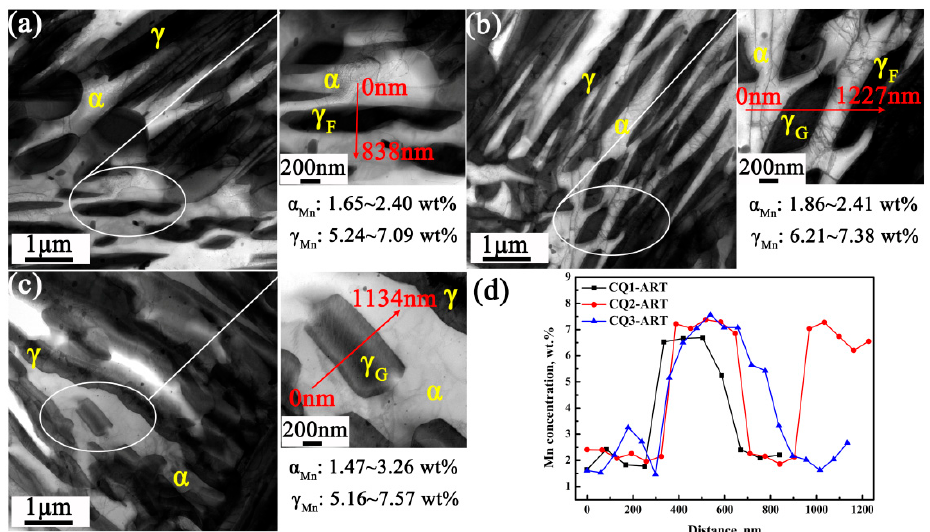
Figure 5. ( a ) TEM image of the CQ1-ART sample; ( b ) TEM image of the CQ2-ART sample; ( c ) TEM image of the CQ3-ART sample; ( d ) corresponding Mn concentrations measured by the TEM-EDS in ( a )–( c ), where γ , γ F, γ G and α refer to austenite, filmy austenite, granular austenite and ferrite, respectively.